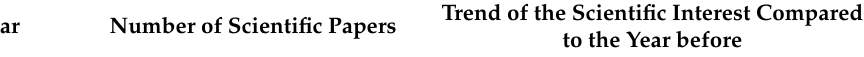
Table 1. The number of scientific documents in the analyzed period and the trend of the scientific interest based on the analyzed keywords. Source: processing done by the authors based on the data interrogated in the Scopus